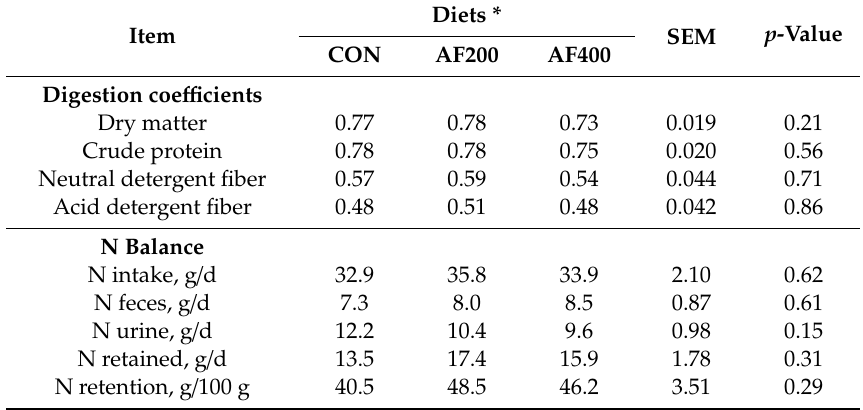
Table 6. Nutrient digestibility and N balance in Awassi lambs fed diets containing alternative feeds (AF). Diets * Item